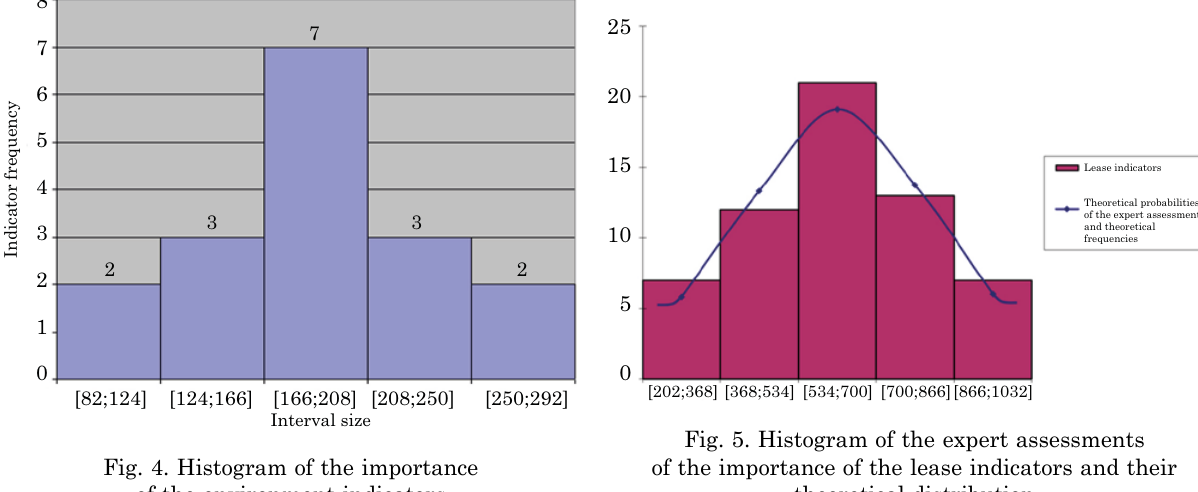
fig. 5. Histogram of the expert assessments of the importance of the lease indicators and their theoretical distribution